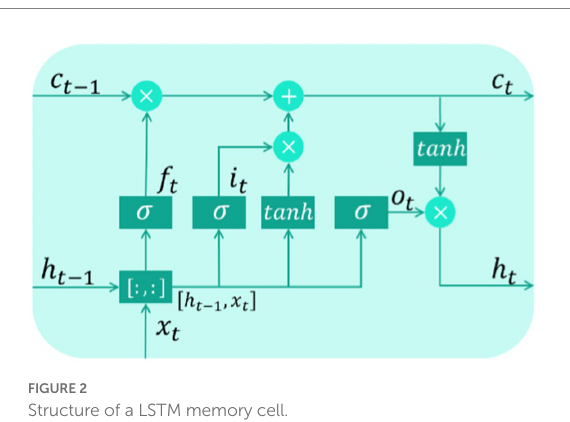
FIGURE 2 Structure of a LSTM memory